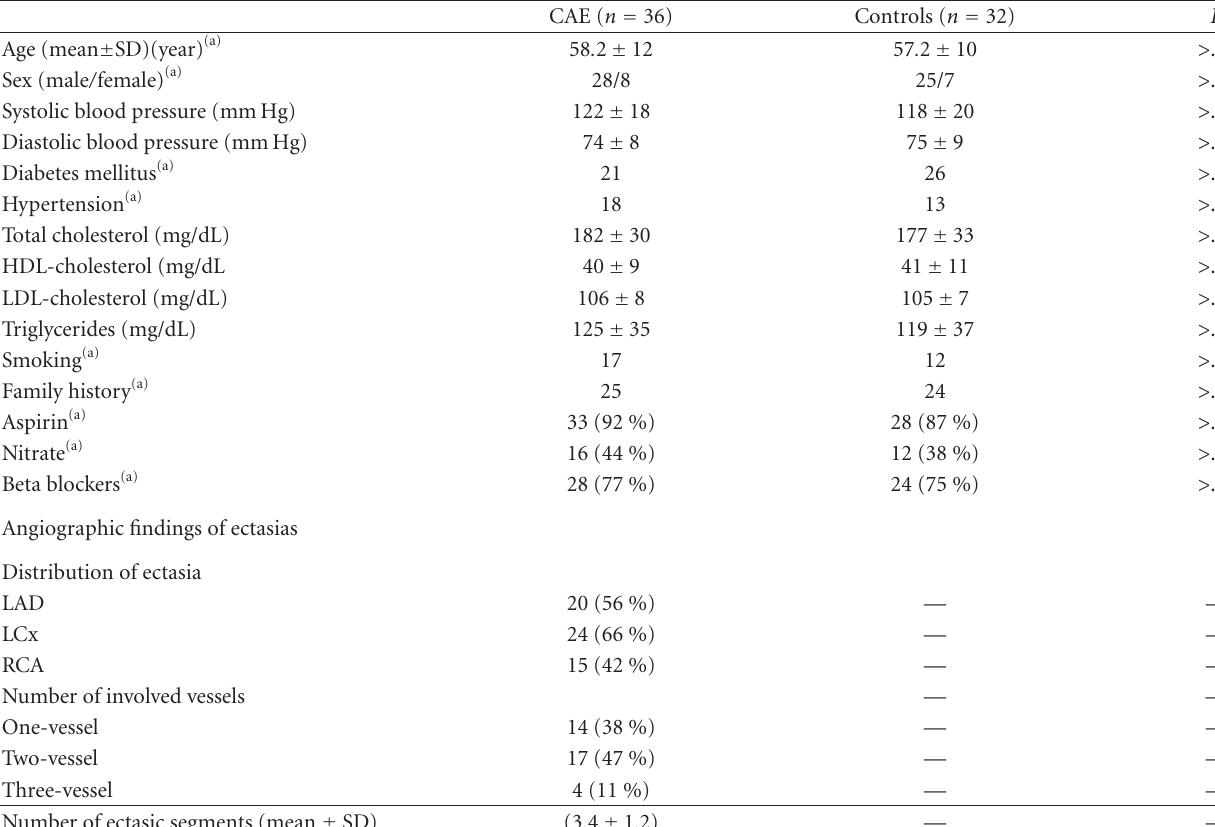
Table 1: Clinical and coronary angiographic characteristics of patients with isolated coronary artery ectasia and controls.